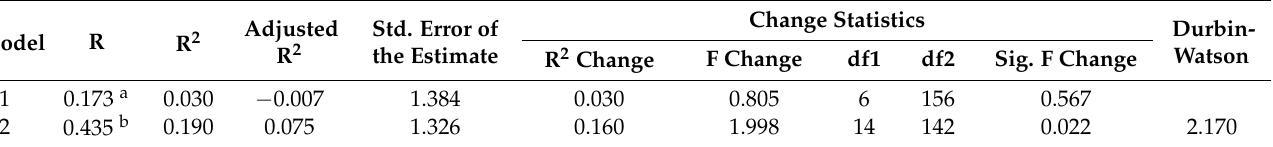
Table 6. Influence of temperature, air, lighting, and comfort on productivity (Model